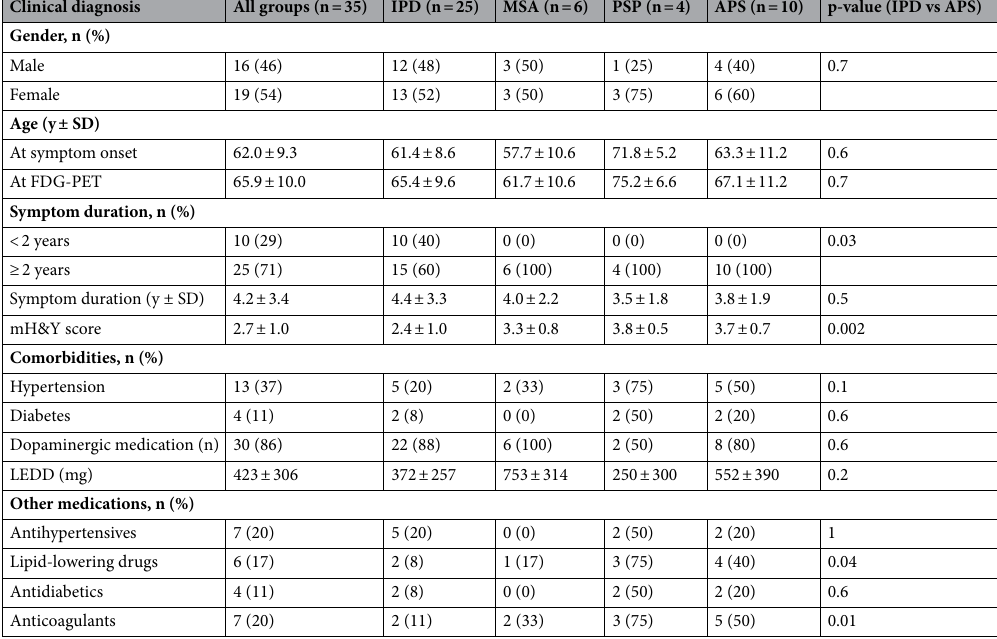
Table 1. Baseline characteristics of the Stockholm cohort. APS atypical Parkinsonian syndromes, FDG-PET 18 F-fludeoxyglucose positron emission tomography, H&Y modified Hoehn and Yahr score, IPD idiopathic Parkinson’s disease, LEDD levodopa-equivalent daily dose, MSA multiple system atrophy, PSP progressive supranuclear palsy, SD standard deviation.